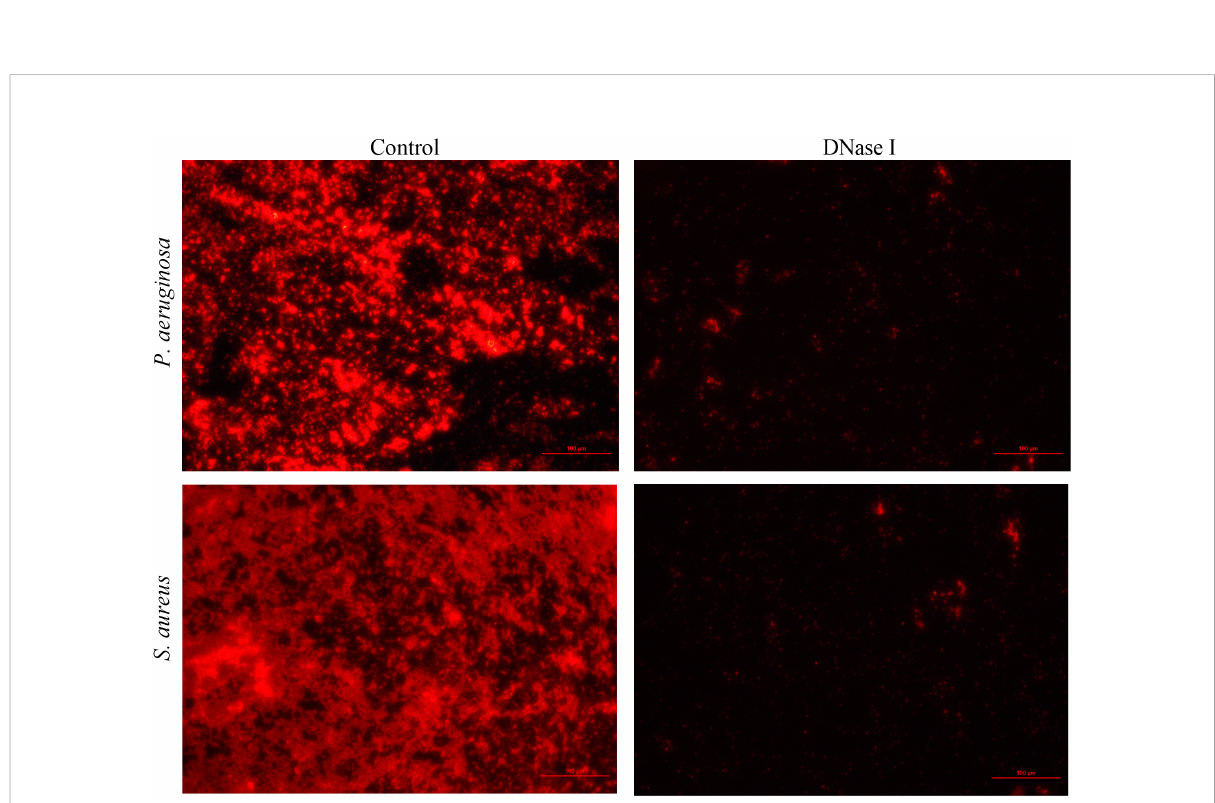
FIGURE 4 Fluorescence microscopy images of P. aeruginosa or S. aureus eDNA (100×). Propidium iodide (PI)-stained eDNA in red. In the DNase I group, the extent of PI staining decreased compared with the extent in the drug-free control group.